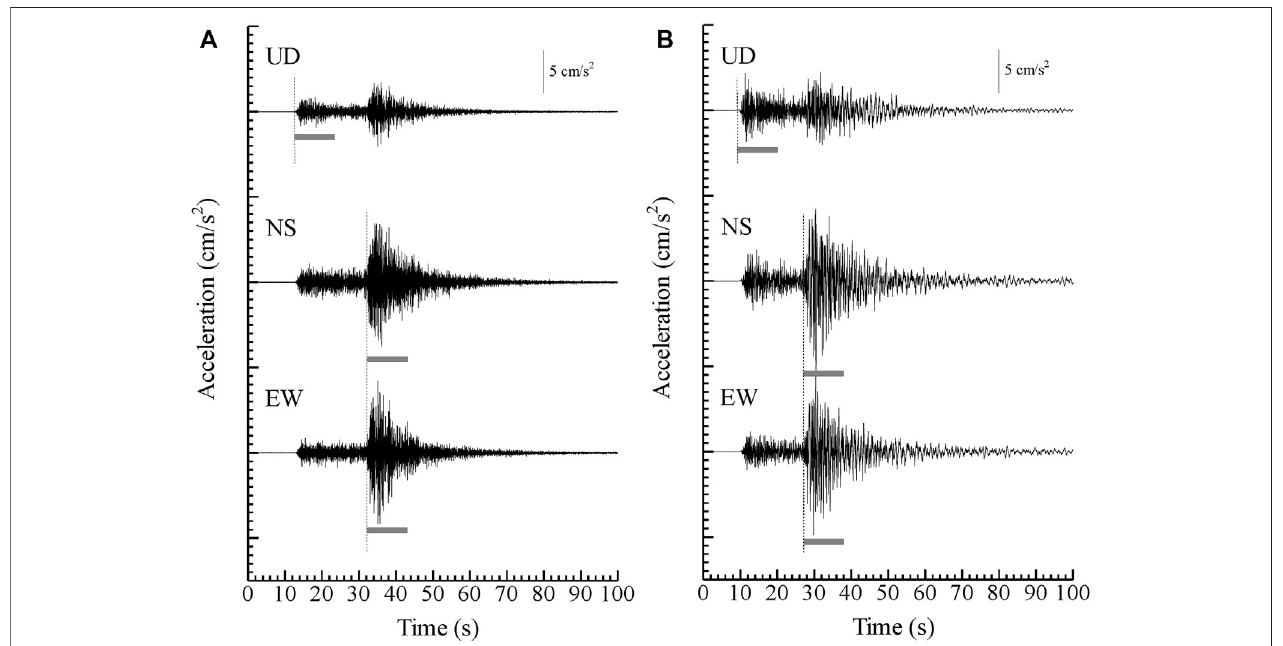
FIGURE3| Waveforms ofacceleration for3components duringanearthquake( Mj 5.9)occurredon11th/April2011observedatKSandSSstations.Brokenlines show an onset of P-wave for UD component and onsets of S-wave for NS and EW components. Under lines show a time-window of 10.24 s for each component, to estimate a spectral ratio of S-wave to P-wave. (A) KS station (B) SS station.